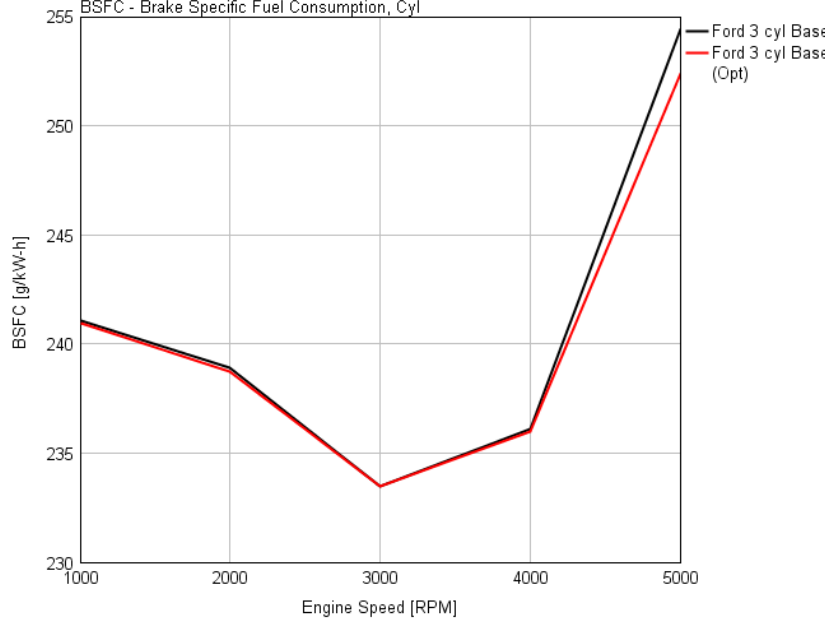
Figure 18. A verage Shaft speed of the baseline models at 1000 rpm engine speed. 6.2. Comparison of the EAT with 1 kW Power Level Models The results obtained from the simulations for the initial and optimized compressor of the electrical assisted turbocharger models with power level 1 kW indicate that there is no significant difference between the two compressors. Figure 19 shows the engine torque versus engine speed for both centrifugal compressors. Even though the two graphs are very similar, there is a slight rise of the torque for the optimized compressor at an engine speed range between 4000 to 5000 rpm.